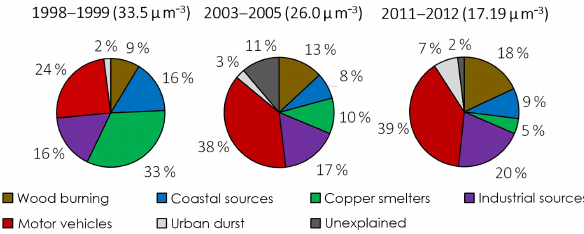
Figure 10. Relative contribution of each source at the beginning, middle, and end of the period investigated in this study. Median levels of total PM 2 . 5 are given in brackets next to the corresponding time